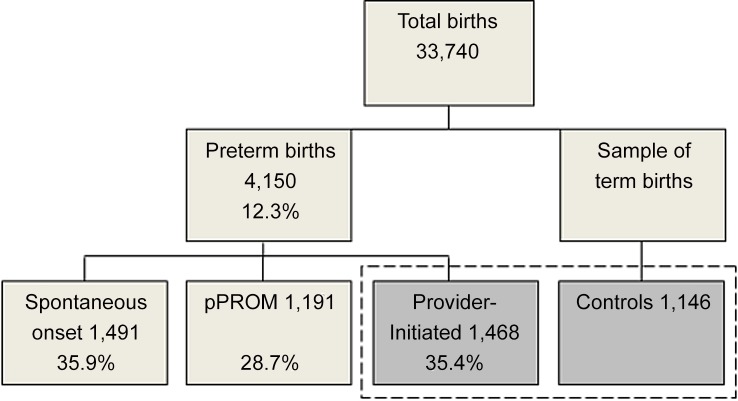
Flow chart of subjects in the Brazilian Multicentre Study on Preterm Birth.